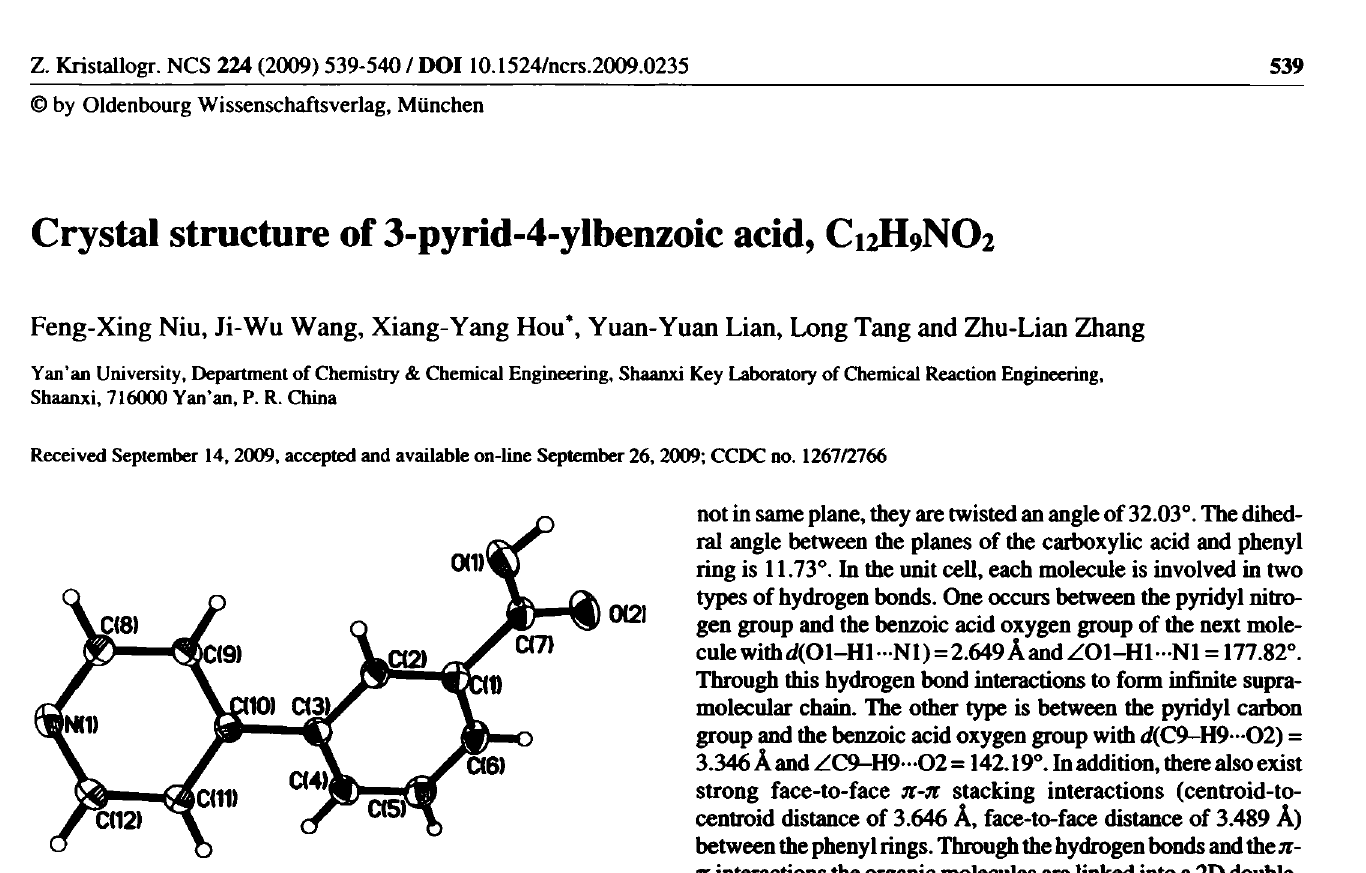
Table 1. Data collection and handling.